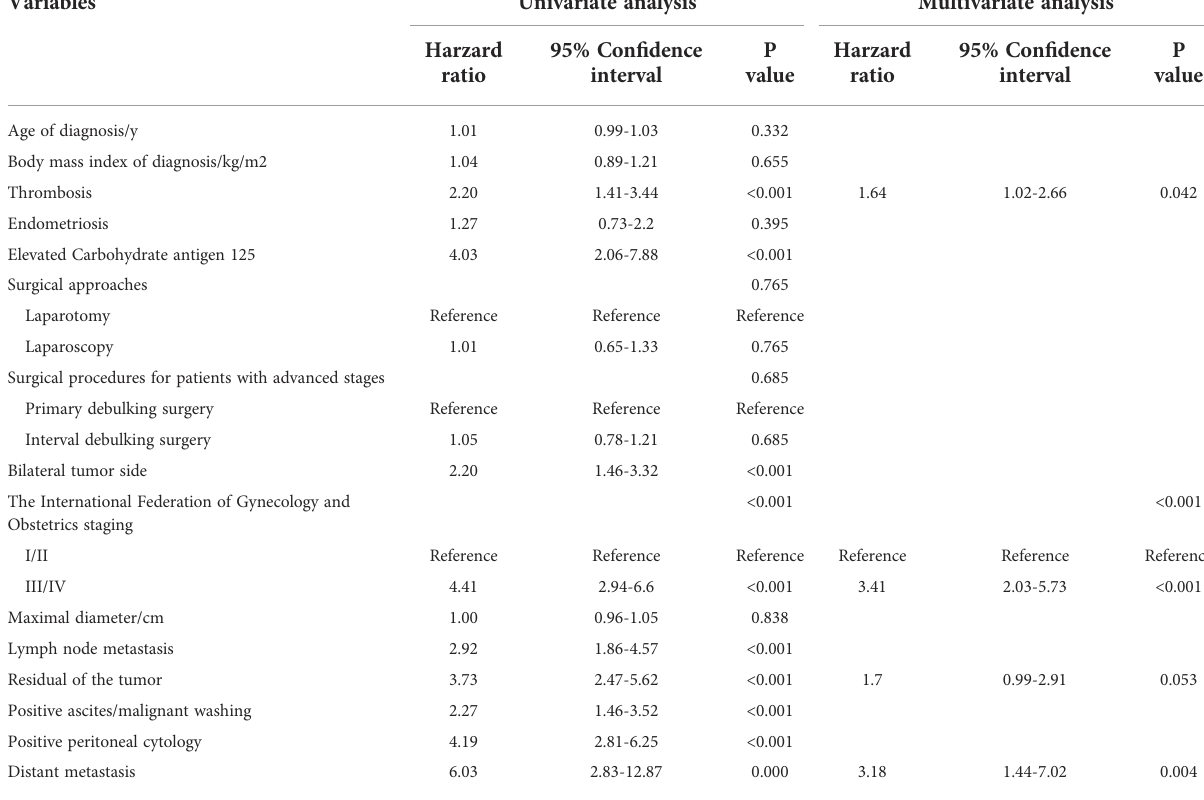
TABLE 2 Progression-free survival of patients with ovarian clear cell